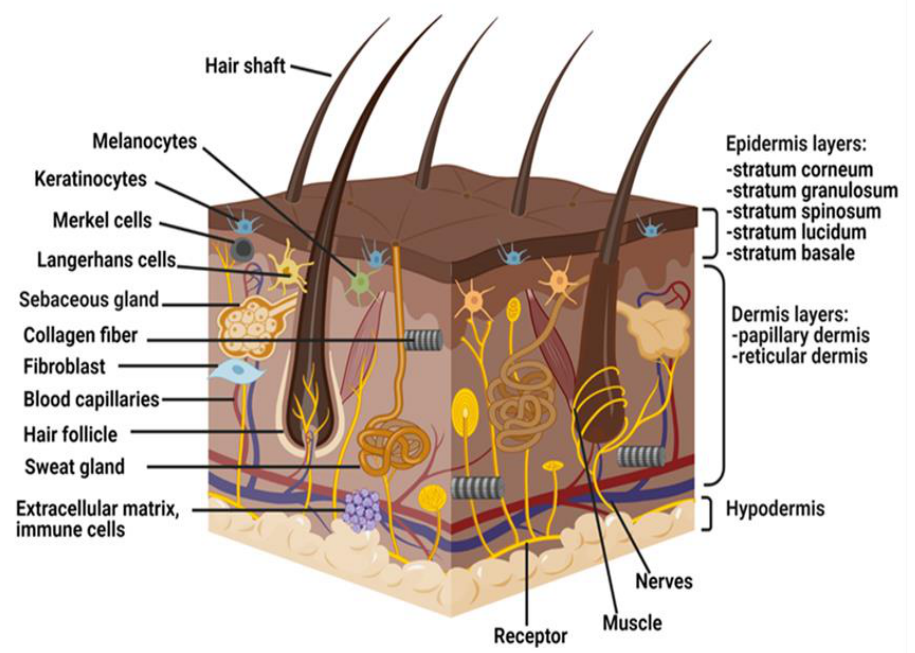
Figure 1. The anatomical structure of human skin